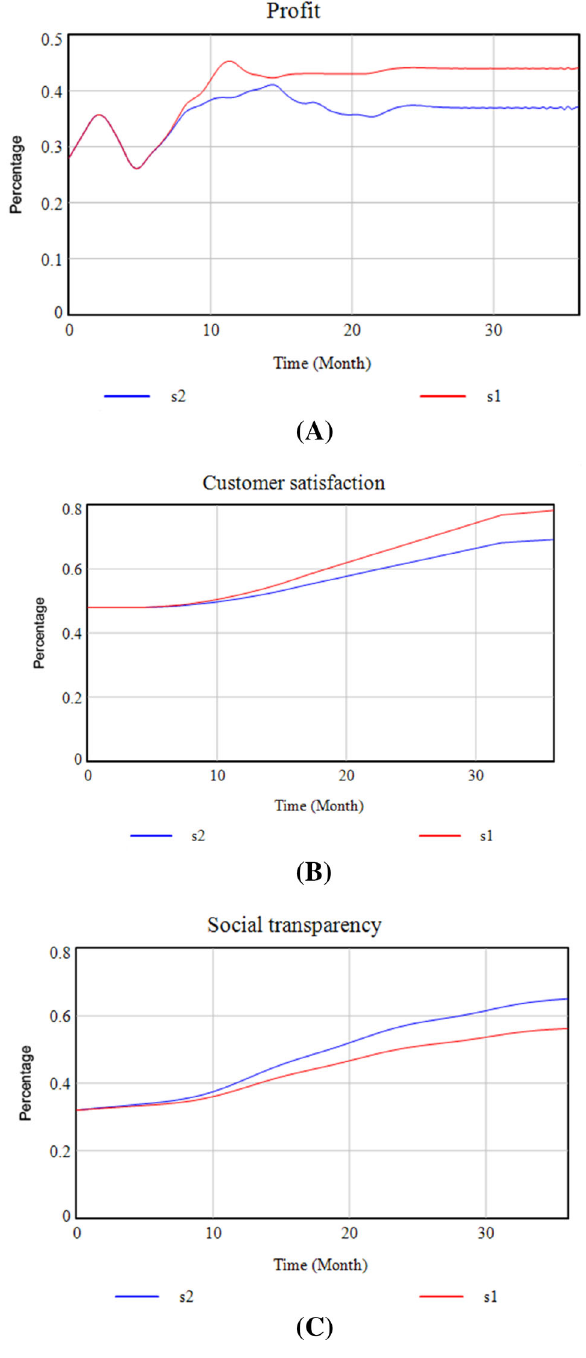
Fig. 13 Testing the scenarios